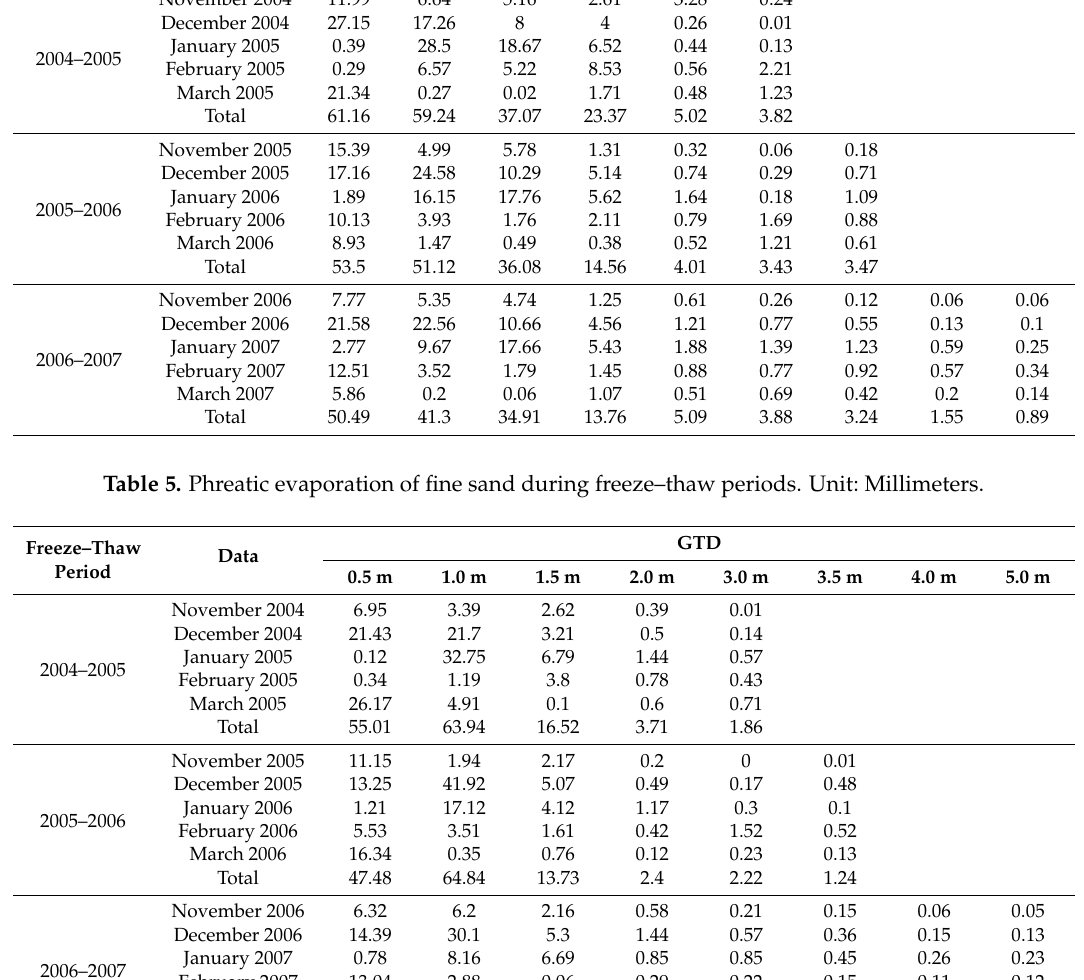
Table 4. Phreatic evaporation of sandy loam during freeze–thaw periods. Unit: Millimeters. Freeze–Thaw Period